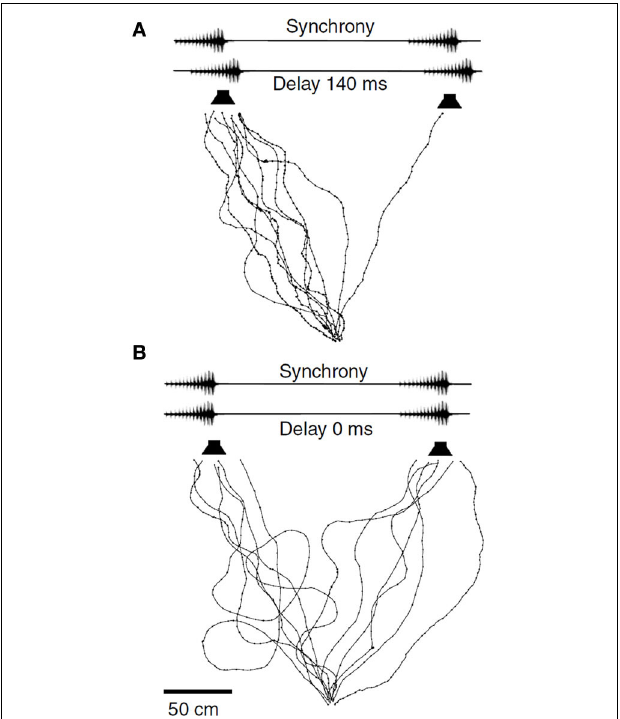
FIGURE 5 | Leader preference in M. elongata . Phonotactic walking paths of females given the choice between identical chirps either presented with a temporal advantage of 140ms from the left (A) or in perfect synchrony (B) Modified from Fertschai et al.